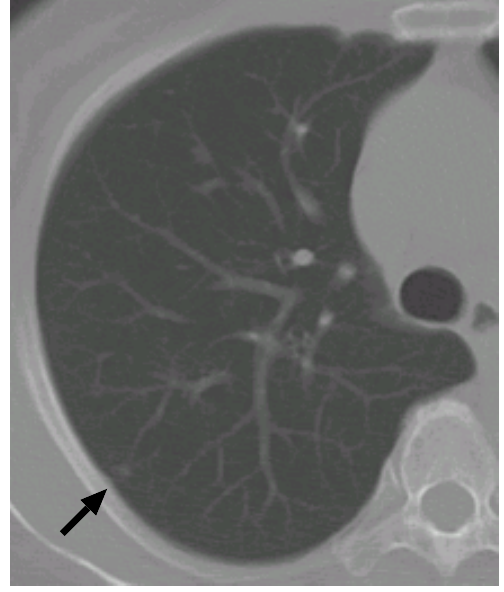
Figure 9. The arrow indicates another nodule.